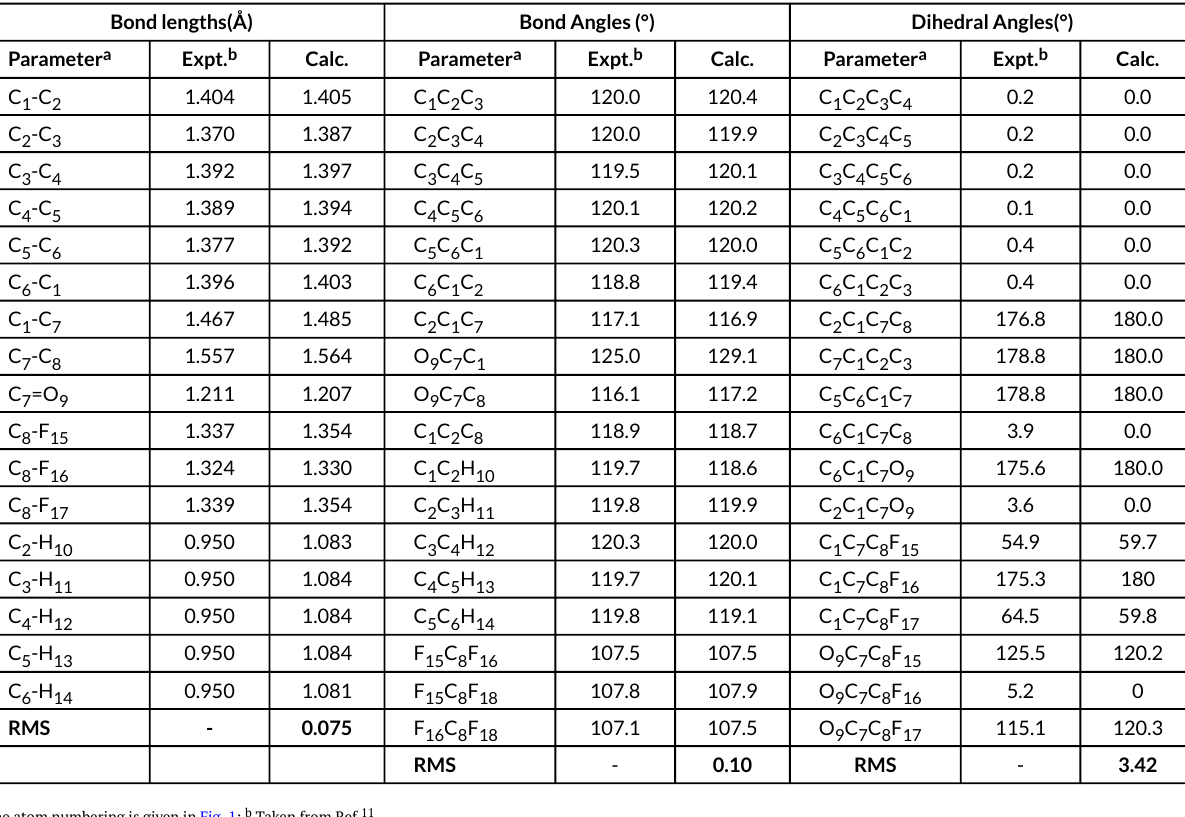
Table 1. Some of the experimental and calculated bond length(Å), bond angle (°) and dihedral angles (°) (for TFAP.